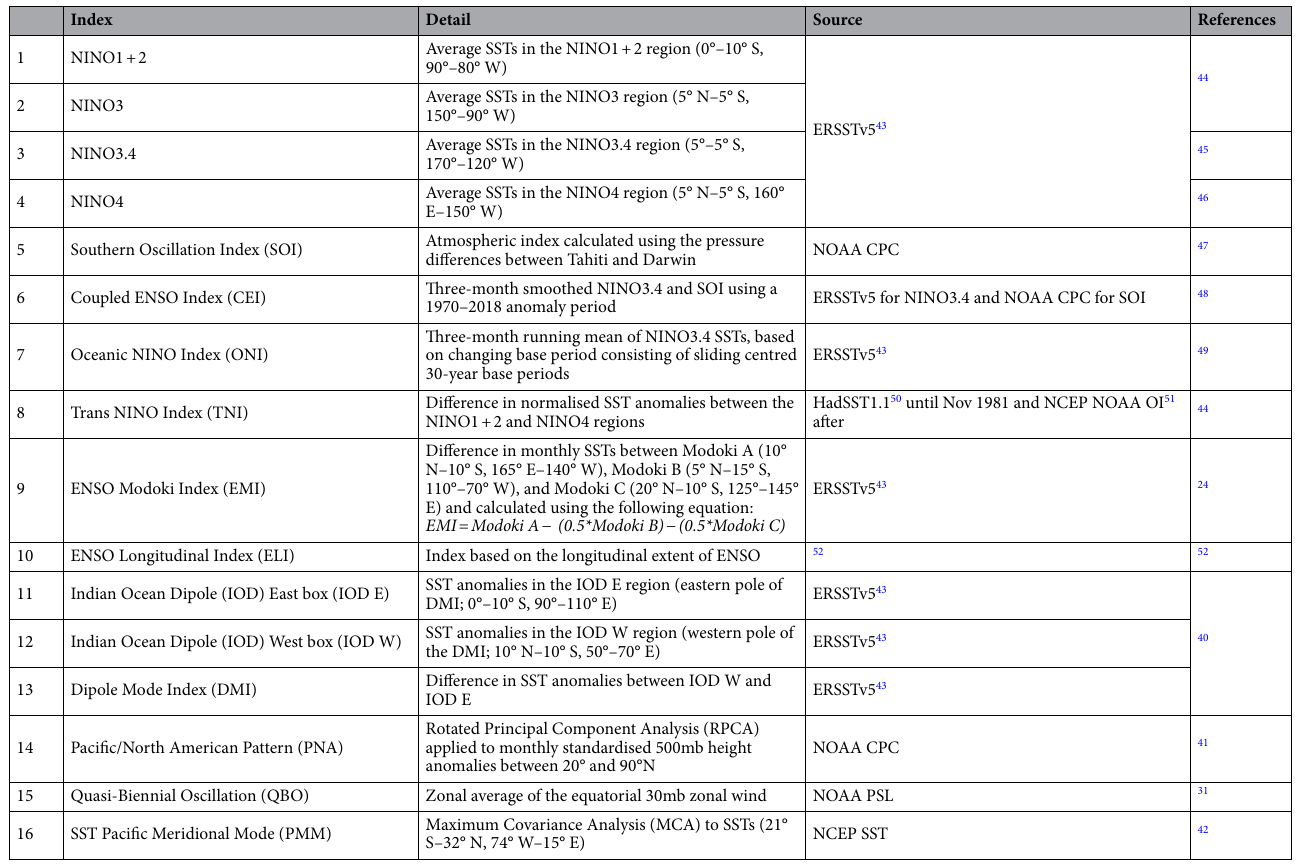
Table 1. Model covariates used to build predictor models, including ENSO indices (1–10) and non-ENSO indices